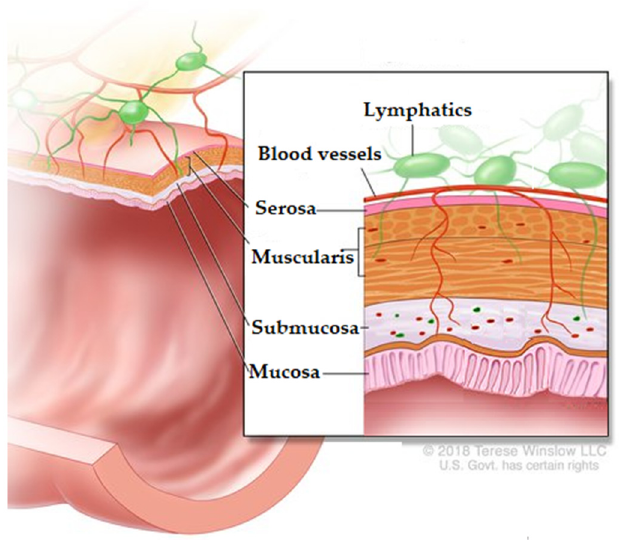
Figure 3. Histological layers of the colon. Adapted from [93]. Rights holder: © (2021) Terese Winslow LLC, U.S. Govt. has certain rights.